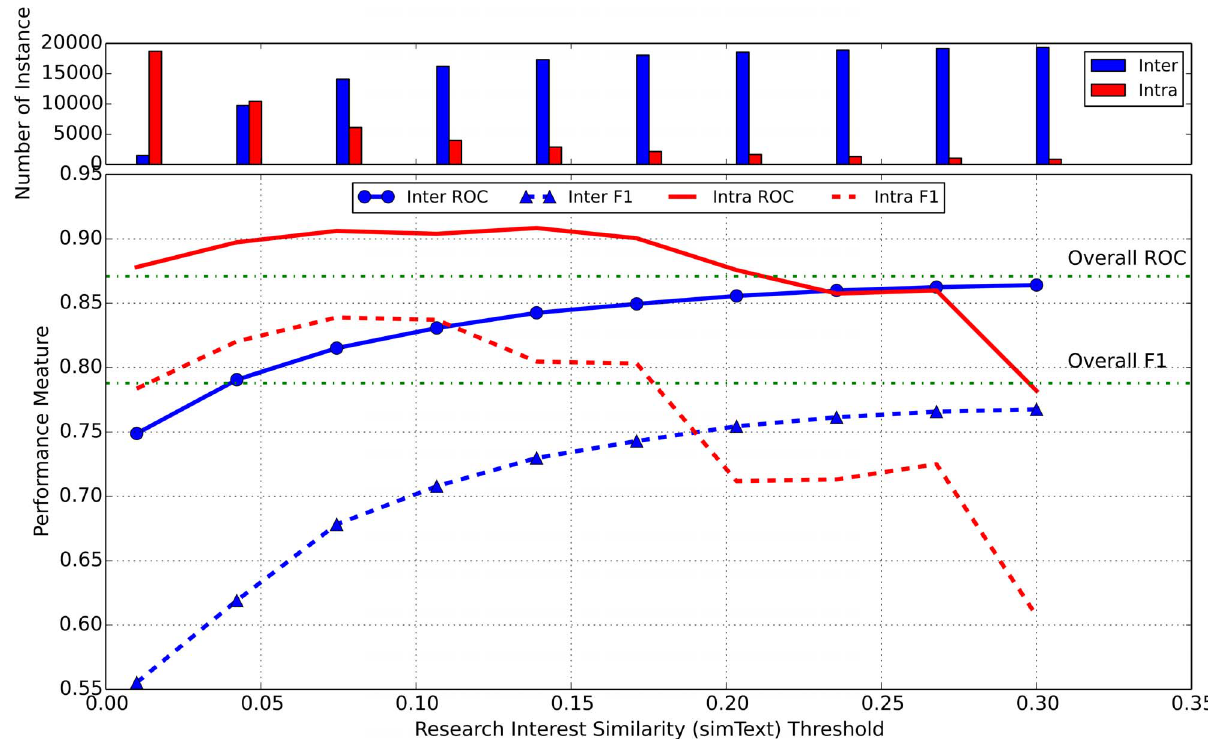
Figure 3. Intra and inter-disciplinary collaboration prediction performance by ROC and F1 measurement. Training set and RandomPairCateory test set were divided by the threshold into inter- ( , threshold) and intra-disciplinary ( . threshold) training/test sets. For each threshold, we trained inter- and intra-disciplinary models and tested them on the corresponding inter-/intra-disciplinary testing sets. The histogram on the top is the number of instances (training + testing) of inter- and intra-disciplinary subset according to the threshold cutoff. The ROC and F1 of overall data are also denoted as the two dotted horizontal lines. doi:10.1371/journal.pone.0111795.g003 PLOS ONE |